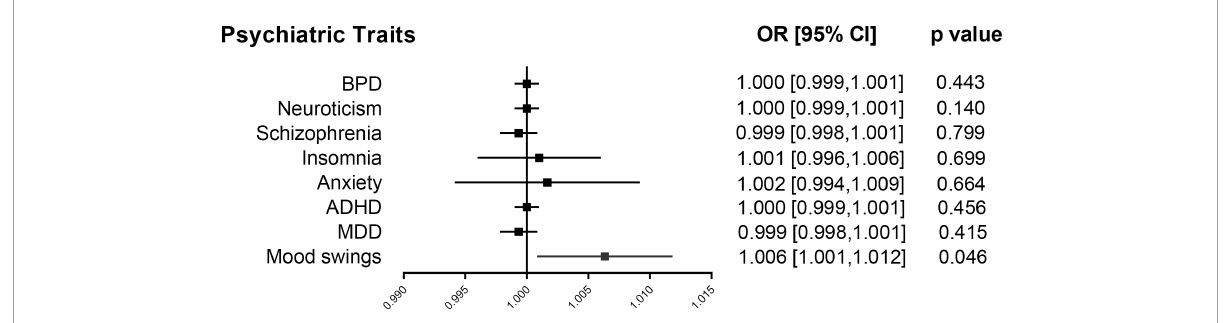
FIGURE4 Forest plot of group A. Mendelian randomization associations for eight psychiatric traits on ICH. Results derived from IVW analyses. ADHD, attention deficit/hyperactivity disorder; BPD, bipolar disorder; CI, confidence interval; ICH, intracerebral hemorrhage; IVW, inverse variance weighted; MDD, major depressive disorder; OR, odds ratio.